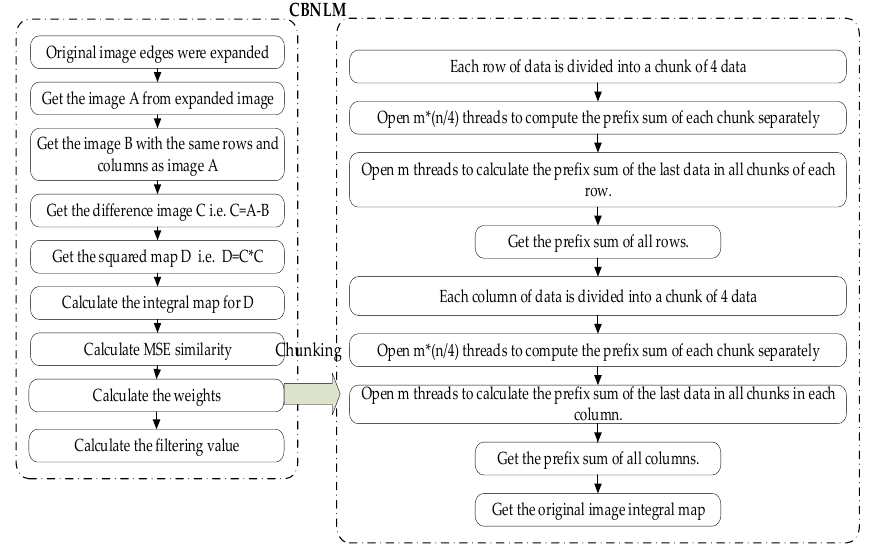
Figure 3. Flowchart of the complete CBNLM.